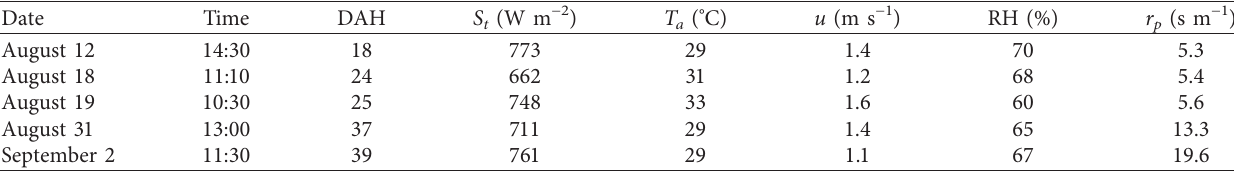
Table 4: r p in the rice paddy field.